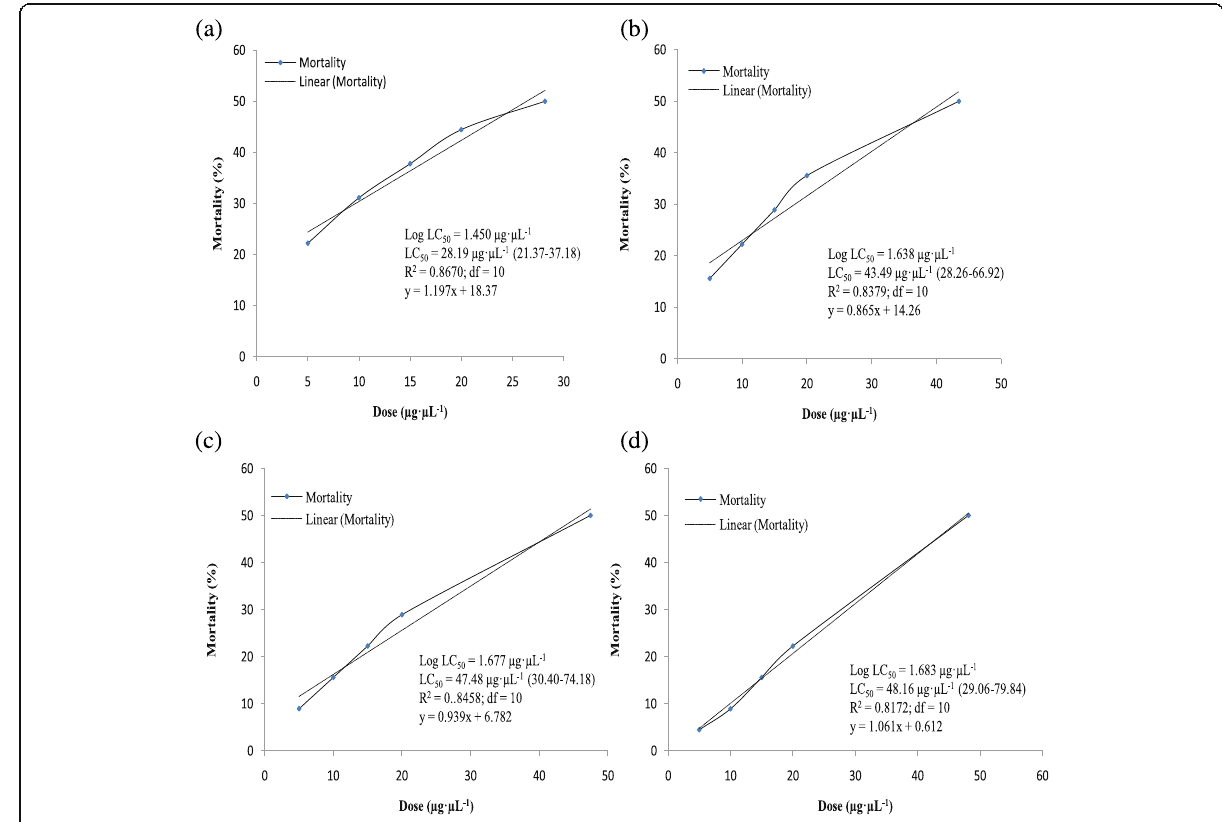
Fig. 1 Dose-mortality (LC 50 ) response to root extracts of W. somnifera against a third instar day 0, b third instar day 1, c third instar day 2, and d third instar day 3 larvae of S. ruficornis . ( R 2 = coefficient of determination; df = degree of